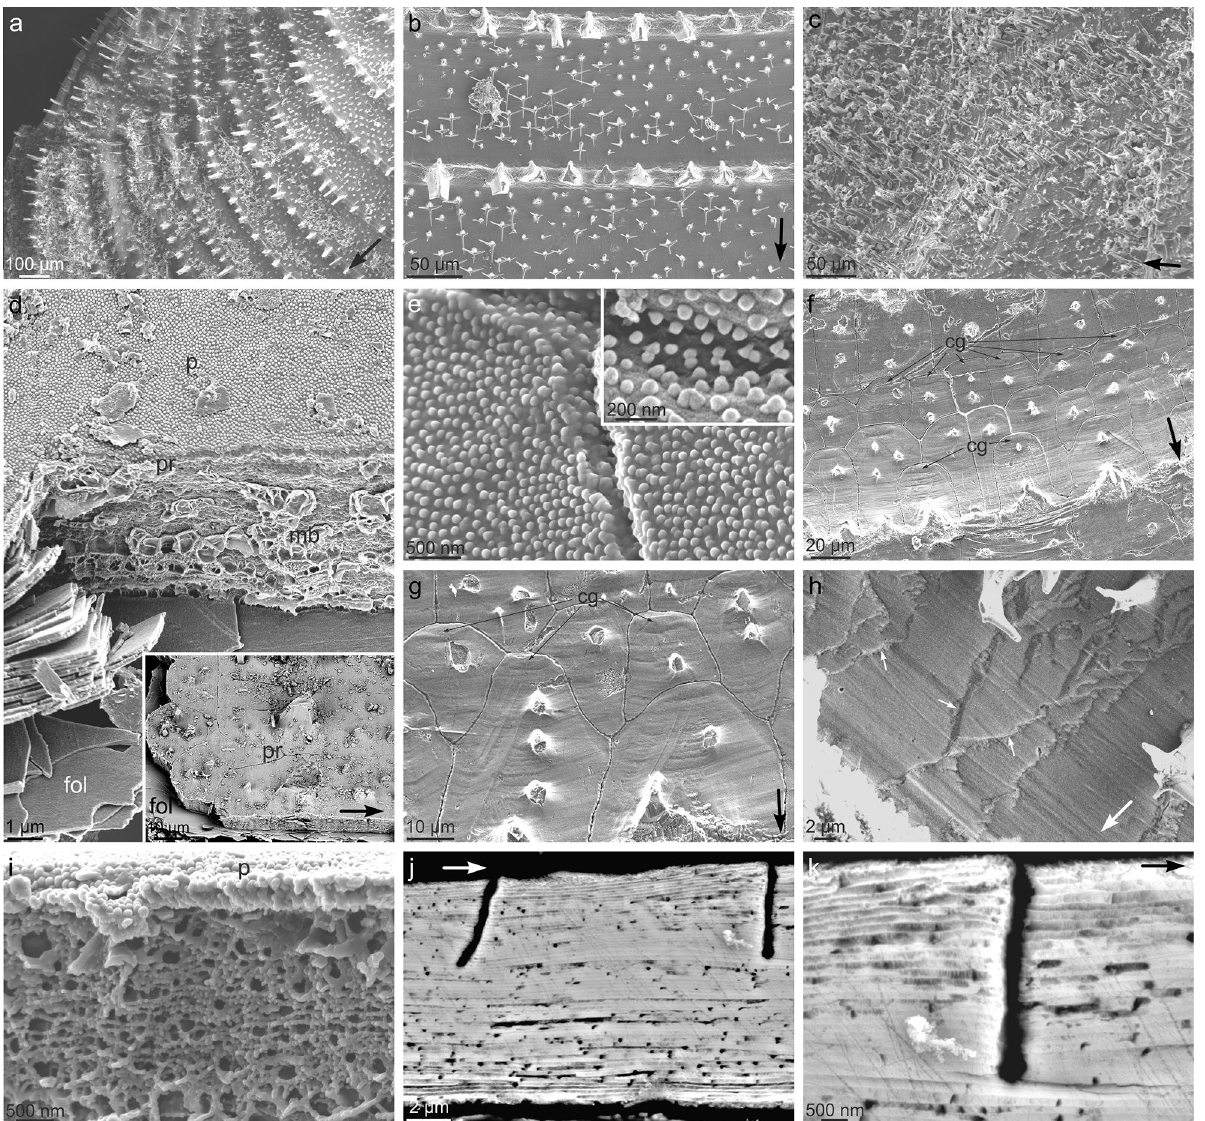
Figure 2. Shell structure of Catillopecten . ( a ) General view of the shell outer surface of Catillopecten natalyae showing the ornament of commarginal ribs and first- and second-order aerials. ( b ) Detail of the first-order aerials of Catillopecten natalyae (broken) protruding from the ribs, and the second-order aerials populating the inter-rib space with a quasiperiodic distribution. ( c ) Aspect of the evenly sized aerials of Catillopecten malyutinae . ( d ) Close up and general view (inset) of the prismatic (pr) and foliated (fol) layers of Catillopecten natalyae . The periostracum (p) covering the prisms and the interprismatic membrane (mb) are also discernible. The set of laths on the left side results from the dismantling of one of the prisms. ( e ) Detail of the periostracum of Catillopecten natalyae . It is characterized by a surface ornament of tiny pimples with slightly conical outlines (inset). ( f ), ( g ) Surface view of the prismatic layer of Catillopecten natalyae . Note the convex adoral outlines of the prisms. The centres of growth (cg) of some of them are indicated. ( h ) Surface view of an area of Catillopecten natalyae where prisms have been replaced by irregular granules elongated in the growth direction (some outlines are indicated with small arrows). ( i ) Detail of the vacuolated membranes of Catillopecten natalyae delineating the individual prisms. The periostracum (p) is to the top. ( j ), ( k ) Two longitudinal sections of Catillopecten malyutinae at different magnifications across the shell. The prisms are made by exactly the same foliated material as the underlying foliated layer. The black slits correspond to the positions of the membranes. The big arrows in ( a ) to ( c ), ( d ) inset, ( f ) to ( h ), ( j ) and ( k ) indicate the growth direction of the